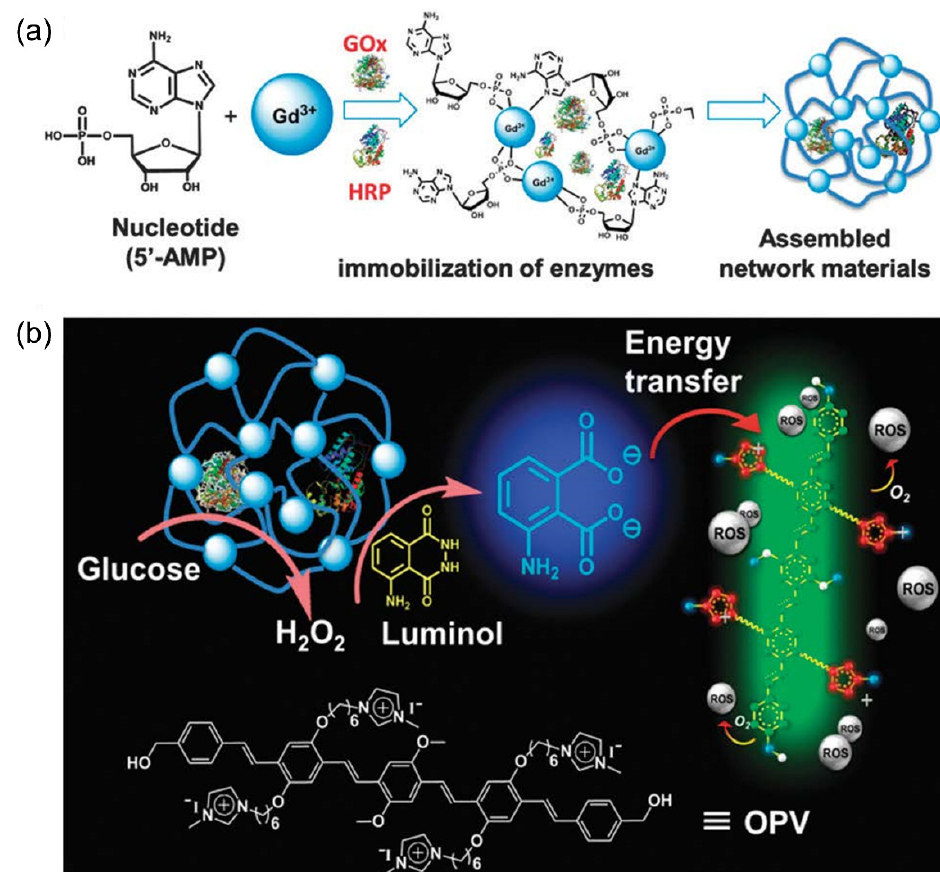
Figure 13. ( a ) Schematic diagram of the preparation of networks containing GOx and HRP. ( b ) Illustration of a glucose-activated BRET system for antimicrobial application without external light source. Reproduced from Ref. [57] with permission from the Royal Society of Chemistry.